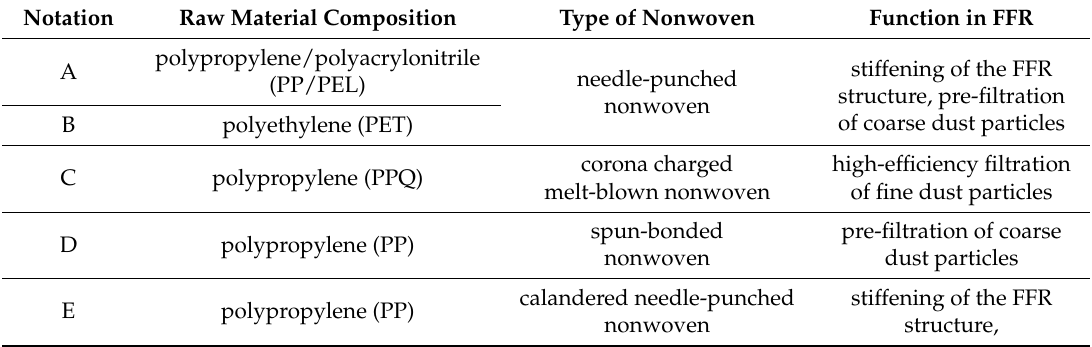
Table 1. Characteristics of filtering nonwovens.